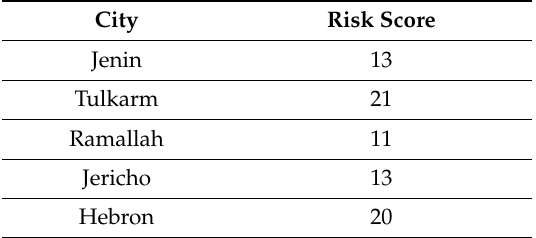
Table 13. Risk score for the ratio of treated water (RTW) (determined from Tables 11 and 12).